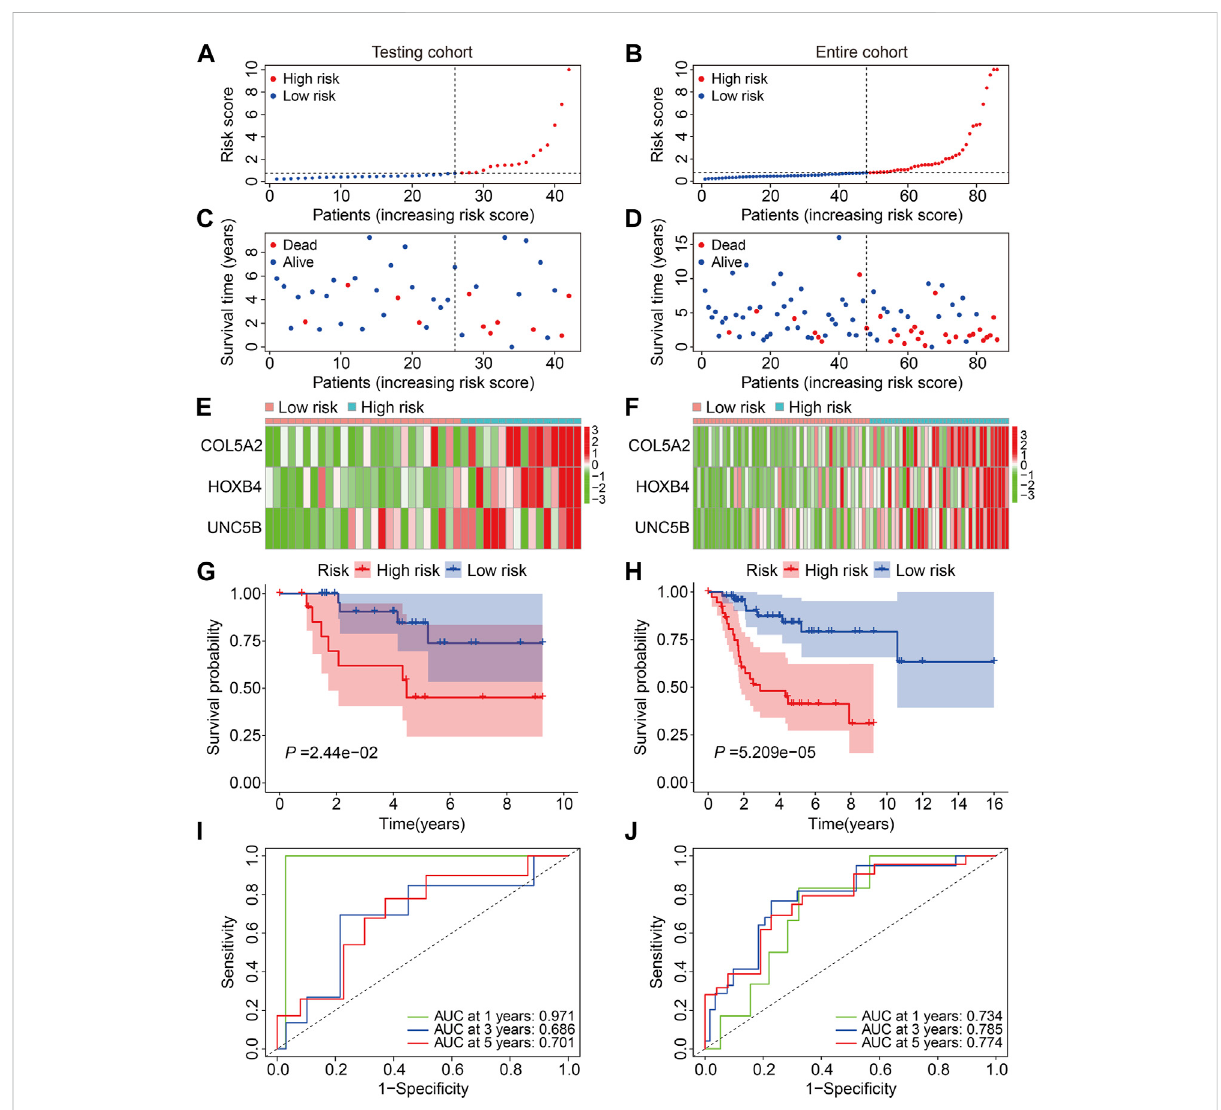
FIGURE 4 Validation of thethree-gene-based prognosticsignature in internalcohorts. (A,B) Risk score distributionin thetestingand entire cohorts. (C,D) Vital status and survival time distribution in the testing and entire cohorts. (E,F) Expression pro fi les of the three FAGs in diverse risk groups of the testing and entire cohorts. (G,H) Kaplan – Meier survival analysis comparing overall survival between the risk groups in the testing and entire cohorts. (I,J) Time-dependent ROC curves for 2-, 3-, and 5-year survival prediction in the testing and entire